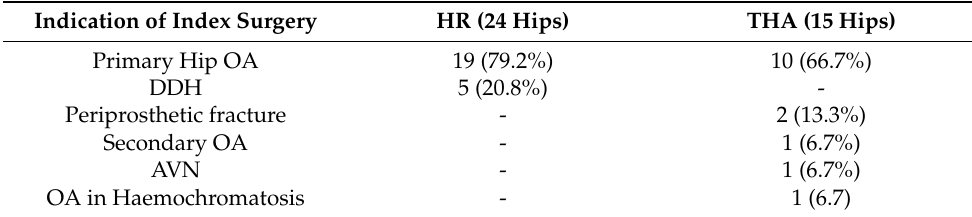
Table 2. Indication of Index